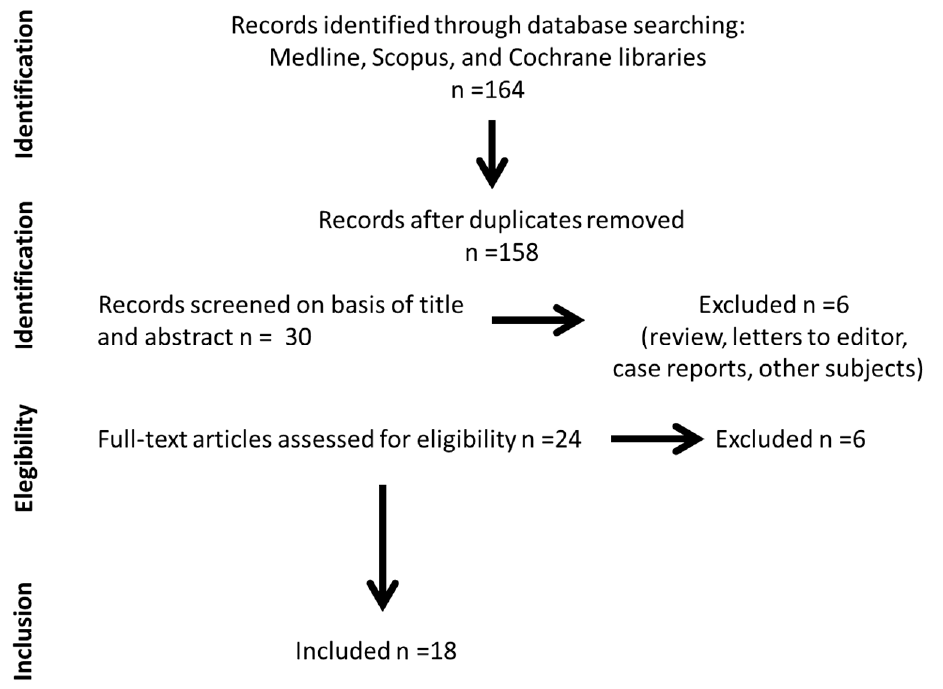
Figure 1. Summary of articles retrieval in scientific databases.